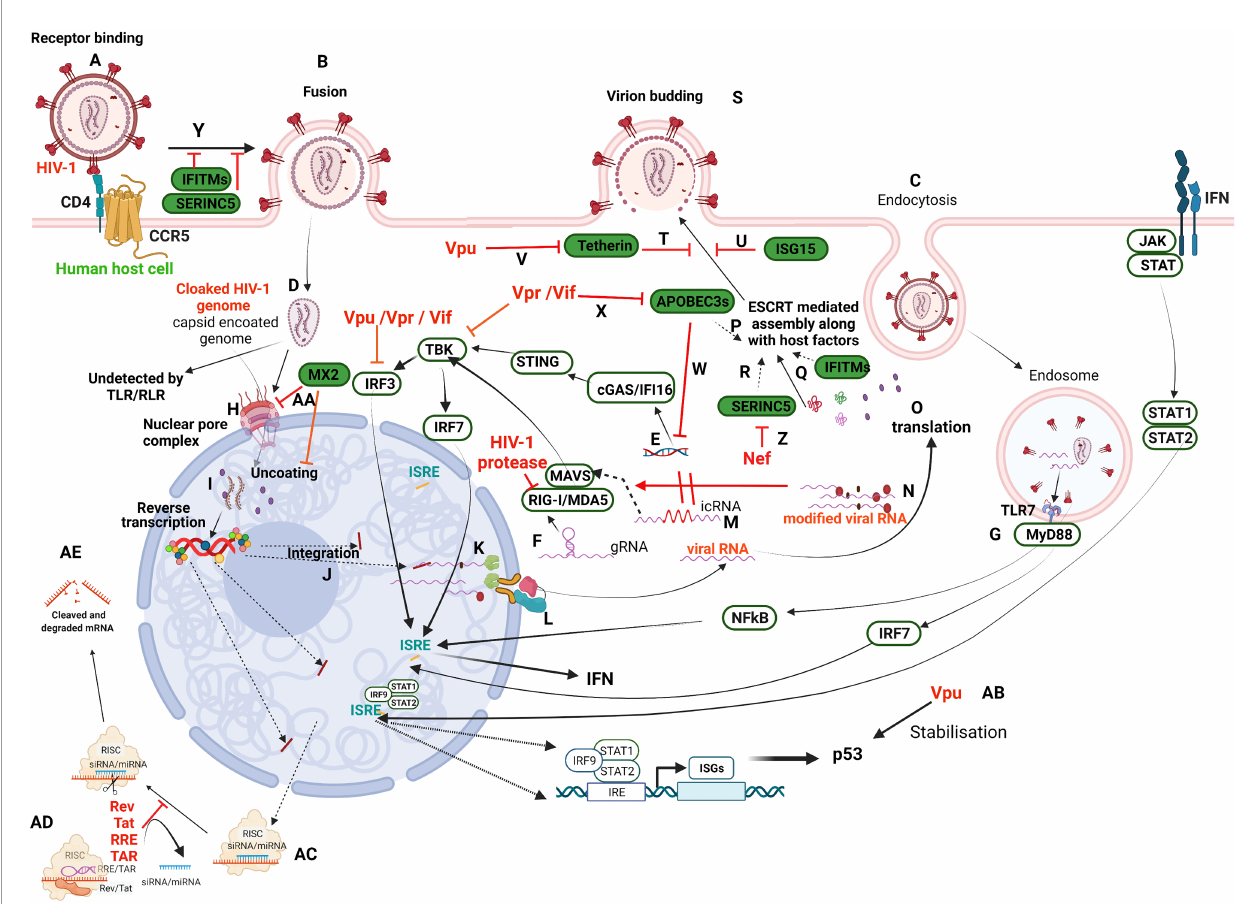
FIGURE 1 | Schematic illustration of HIV-1 infection in a target human host cell and the interception of host restriction pathways by various HIV-1 proteins. HIV-1 infects CD4+ host cells using either of the co-receptors, CCR5 or CXCR4 (here CCR5) (A) to fuse with the plasma membrane (B) or undergoes receptor-mediated endocytosis (C) and various other modes (not in the scope of the present review). Irrespective of the mode of entry, the viral capsid-coated core is released into the cytoplasm (D) . Any viral nucleic acids, probably by leakage/disassembly of capsid core, would trigger the pattern recognition receptors present either in the cytosol, such as IFI16 and cGAS (E) that recognize viral DNA, or RLRs (RIG-I/MDA5) that recognize viral RNA (F) , as well as in endosomes such as TLRs (TLR7) that recognize viral RNA (G) . However, the cloaked (coated by capsid) genome escapes recognition by these receptors and enters the nucleus through the nuclear pore complex (NPC) (H) . The new school of thought concerning early events of the HIV-1 life cycle is that reverse transcription and uncoating occur in the nucleus (I) against the classical theory of these events in the cytoplasm. Once integrated (J) , the viral transcripts are made from pro-viral DNA with some incompletely/partially spliced and some completely spliced (K) . All the viral transcripts are exported from the nucleus with the hijacked host RNA transport machinery (L) . The incompletely spliced intron-containing RNA transcripts (icRNA) are recognized by PRRs in cytosol (M) that activate either IRF3 or IRF7 through MAVS. However, the IRF3 activation is inhibited by viral proteins, Vpu/Vpr/Vif. The viral RNA is modi fi ed by exploiting the host RNA methyltransferase machinery (N) to evade RLR recognition (RIG-I and MDA5). Besides, RIG-I is also targeted by HIV-1 protease. The viral transcripts are translated to produce regulatory proteins (Rev, Tat), accessory proteins (Vpr, Vif, Vpu, Nef) and structural and enzymatic polyproteins (Gag, Pol, Env) (O) . The viral proteins and its genome are assembled into budding virions along with host factors that include RFs (APOBEC3s, (P) ; IFITMs, (Q) ; SERINC5, (R) using host machinery, ESCRT. Viral budding occurs from the host plasma membrane (S) , which is targeted by Tetherin (T) and ISG15 (U) . The viral protein Vpu targets Tetherin (V) . APOBEC3s inhibit reverse transcription of viral RNA (W) and are targeted by Vif/Vpr (X) . IFITM and SERINC5 incorporated into virion inhibit receptor binding and thus fusion (Y) . SERINC5 is degraded by Nef (Z) . The host factor MX2 inhibits the nuclear import of DNA and uncoating steps in the viral life cycle (AA) . Vpu stabilises host ISGs such as p53 that leads to apoptosis of the infected cell (AB) . RRE/TAR and Rev/Tat bind to TRBP in the miRNA loaded RISC complex (AC) to displace siRNA/miRNA from RISC complex resulting in suppression of RNAi (AD) that otherwise leads to activation of RISC signalling and cleavage of transcripts (AE) . Refer to text for details. This representative fi gure re fl ects several possible pathways and is not intended to re fl ect the changes in a single cell. Created with